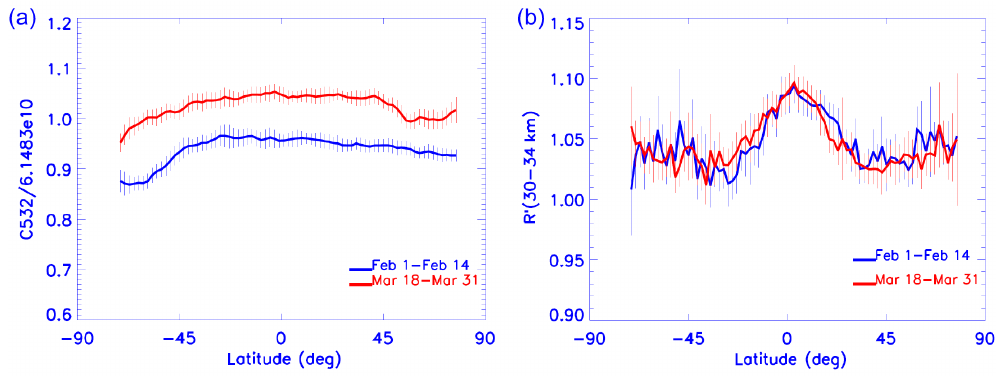
Figure 13. (a) Means and SDs of the zonally averaged 532nm calibration coefficients normalized by 6 . 1483 × 10 10 km 3 srJ − 1 count, and (b) mean and SD of R (cid:48) averaged over 30–34km. Both time series were calculated using 2 weeks’ worth of data before (1–14 February 2009) and after (18–31 March 2009) the laser switch. R (cid:48) profiles were calculated over 2 ◦ latitude intervals from each granule and then averaged over all granules for the latitude bin, with a minimum number of 50 R (cid:48) profiles required in each bin. Data over the SAA were not included.